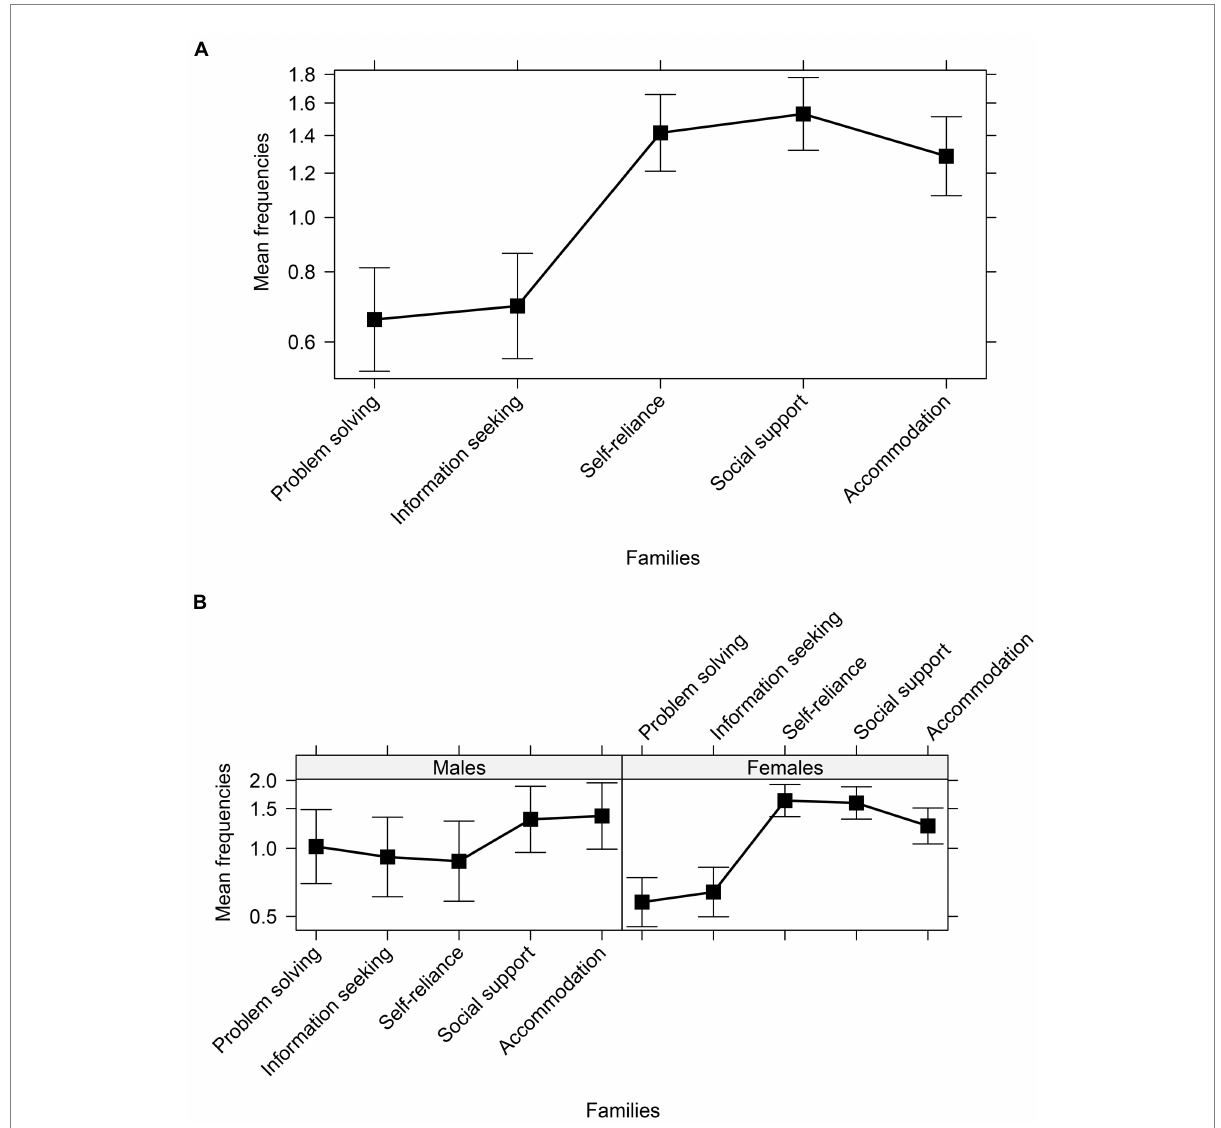
FIGURE 2 Families of coping strategies as coded in the survey of lay adults, (A) for the whole sample, and (B) separately by males and females. The bars represent the 95%